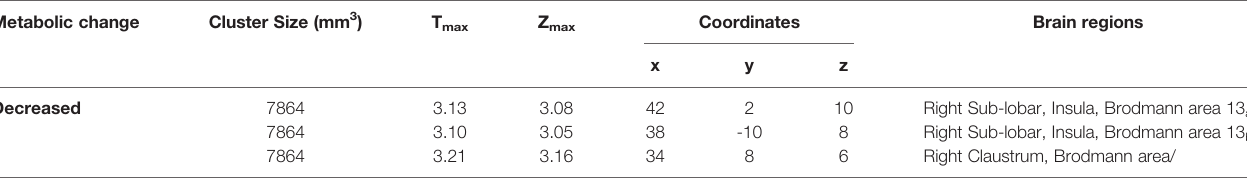
TABLE 2 | Areas of signi fi cant differences of glucose metabolism in subjects with activated BAT (BAT-positive group), compared with controls (BAT-negative group)*. Metabolic change